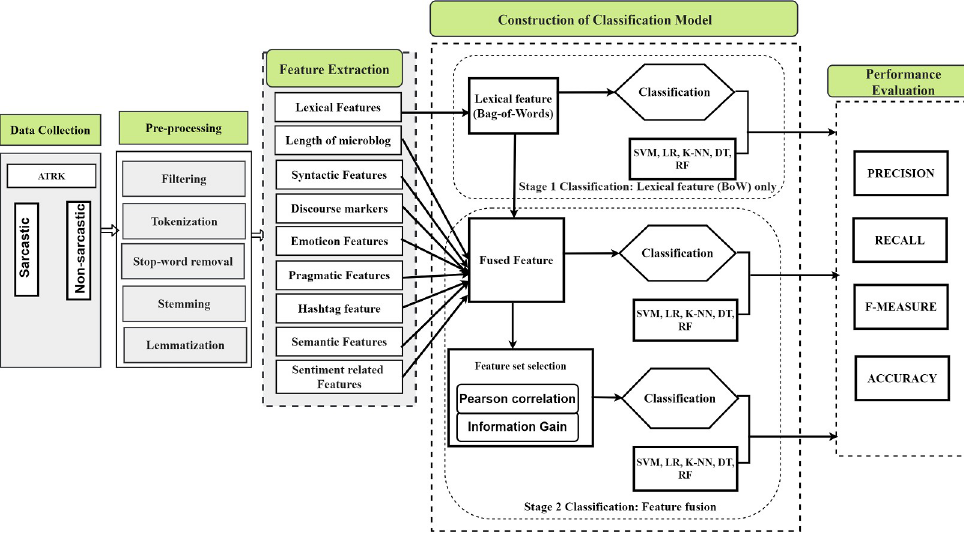
Fig 1. Multi-feature fusion framework for sarcasm